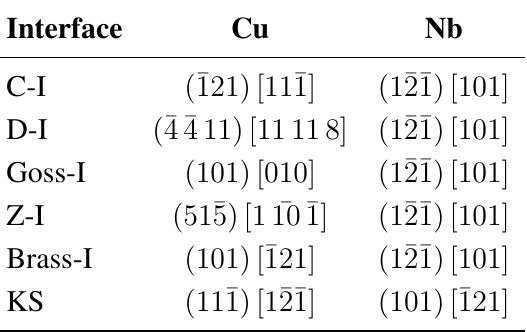
Table 1. Interface Oreintation Relationships ( ND ) [ RD ]